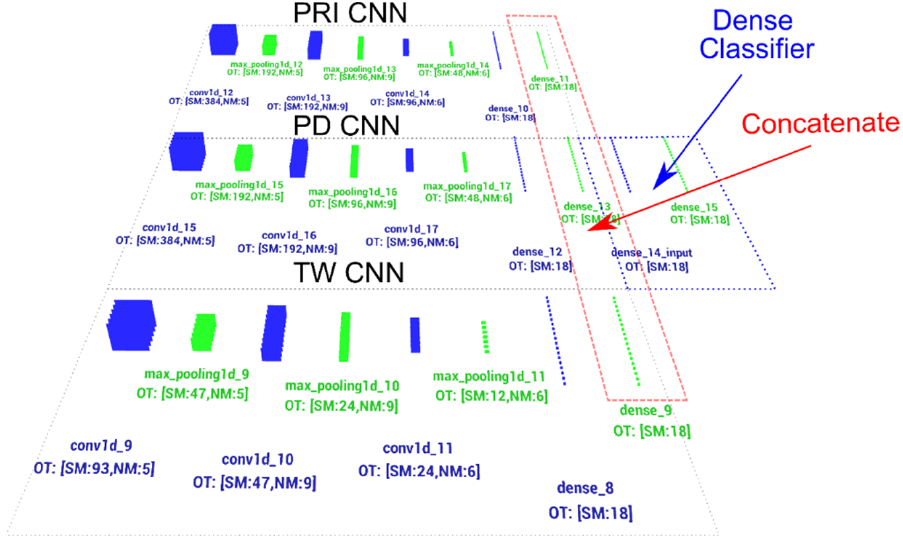
Figure 8. CNN structure for radar signals recognition based on the simultaneous analysis of PD, PRI and TW (RF + PD) parameters. Table 4. Detailed structure of CNN designed for radar signal recognition with simultaneous input of three signal parameters (PRI, PD, TW).